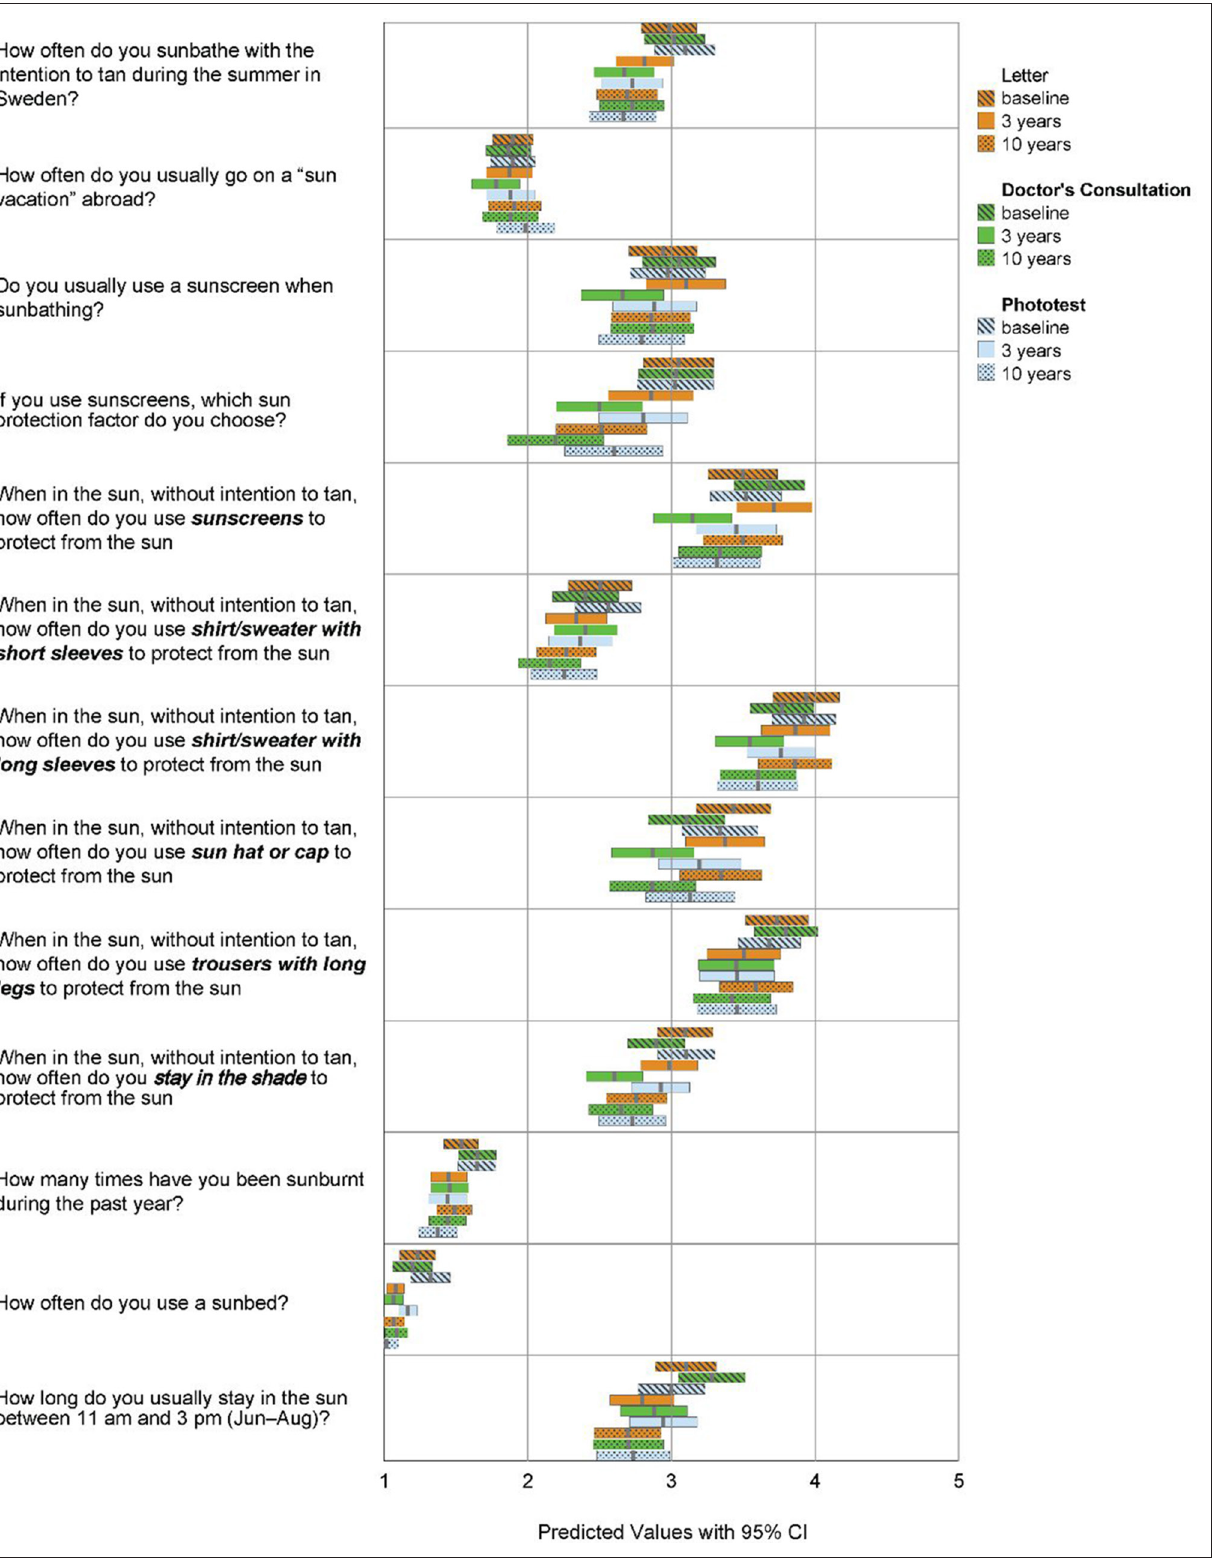
Figure 2 Predicted mean response values with 95% CI on each of the questions regarding sun habits and sun protection behaviour, at baseline and at 3- and 10-year follow-up, in each of the three intervention